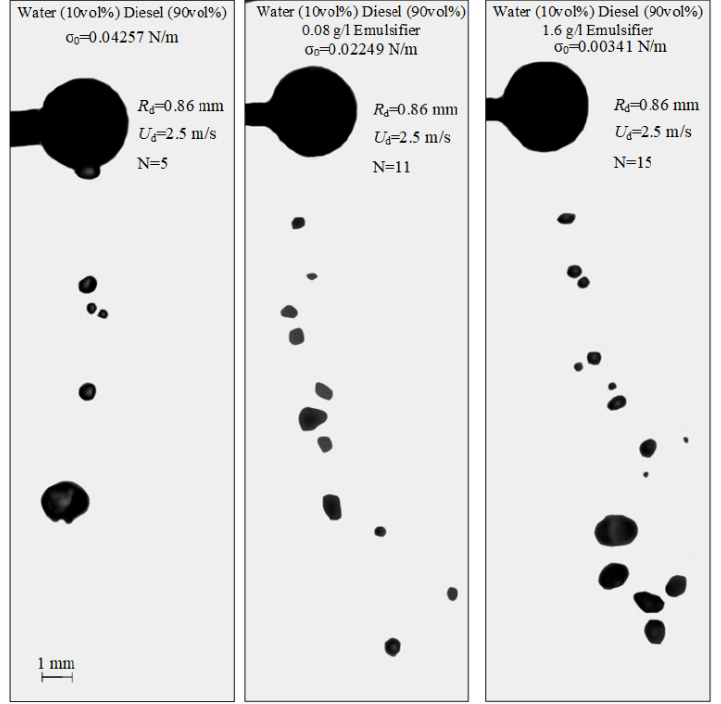
Figure 8. Images illustrating the collisions of water droplets with a particle in stretching separation regime at varying interfacial tensions of liquid.